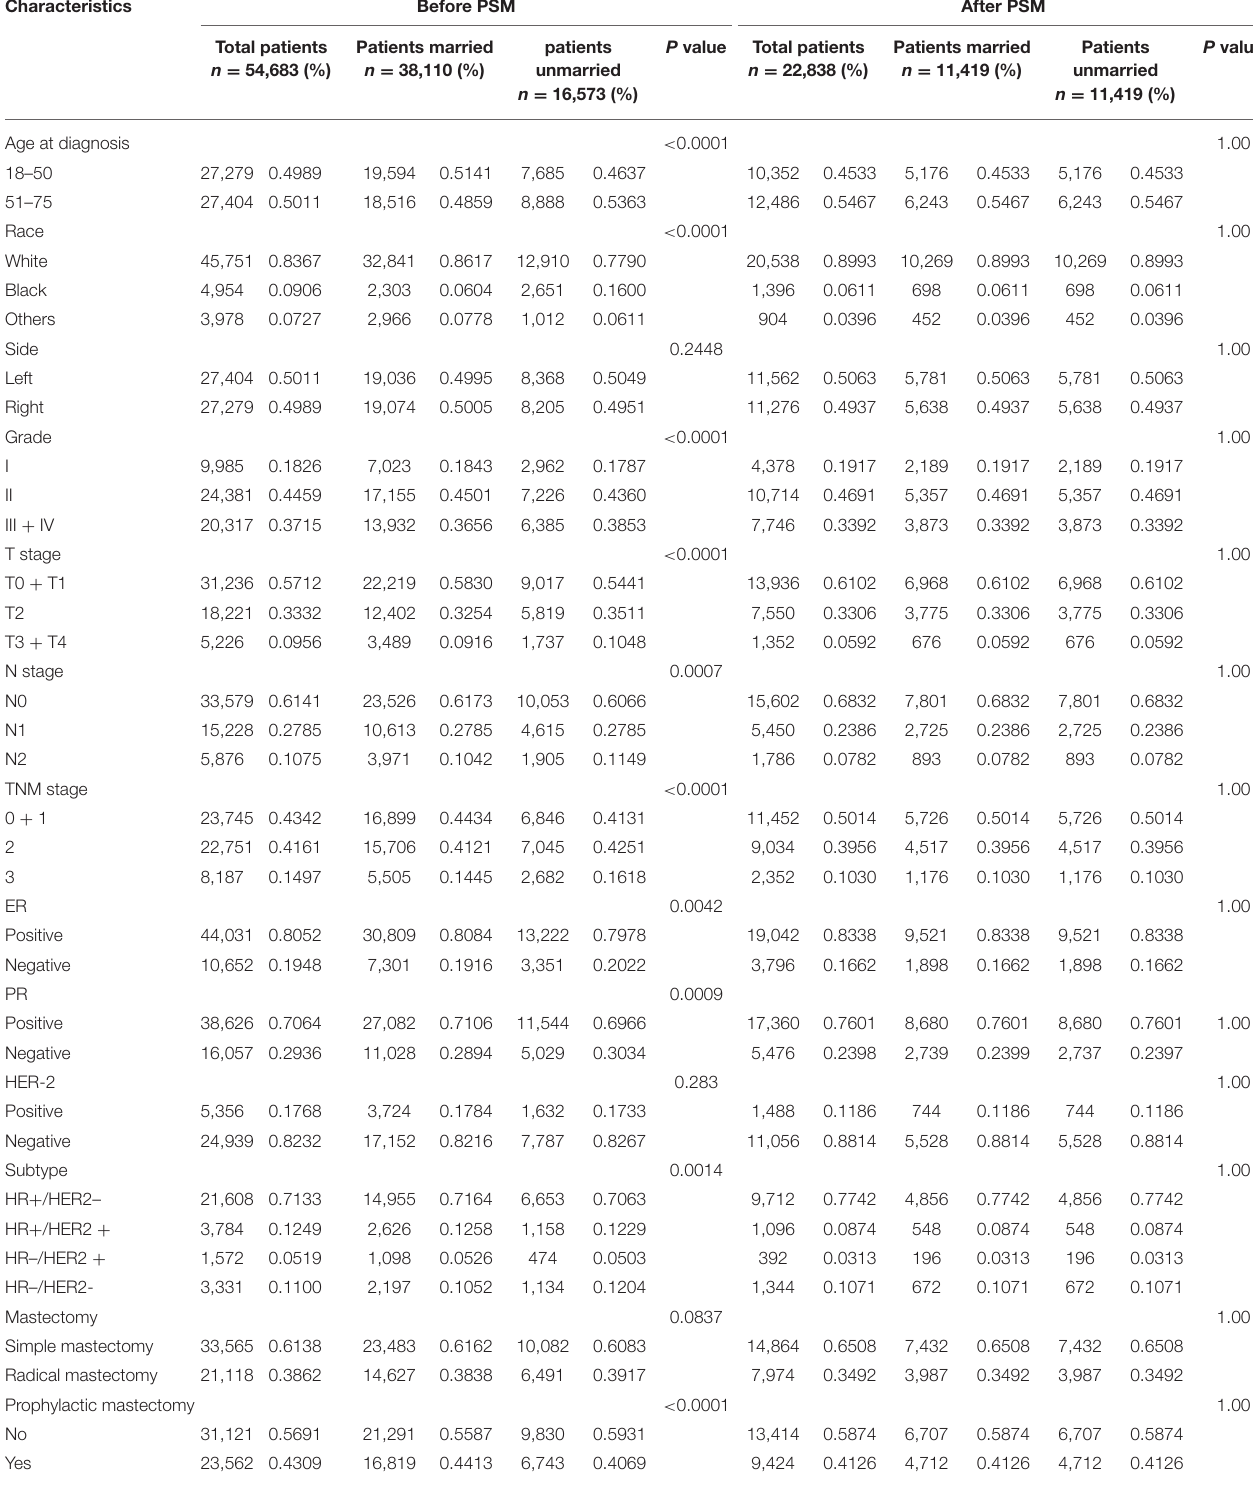
TABLE 1 | Characteristics of married and unmarried patients.